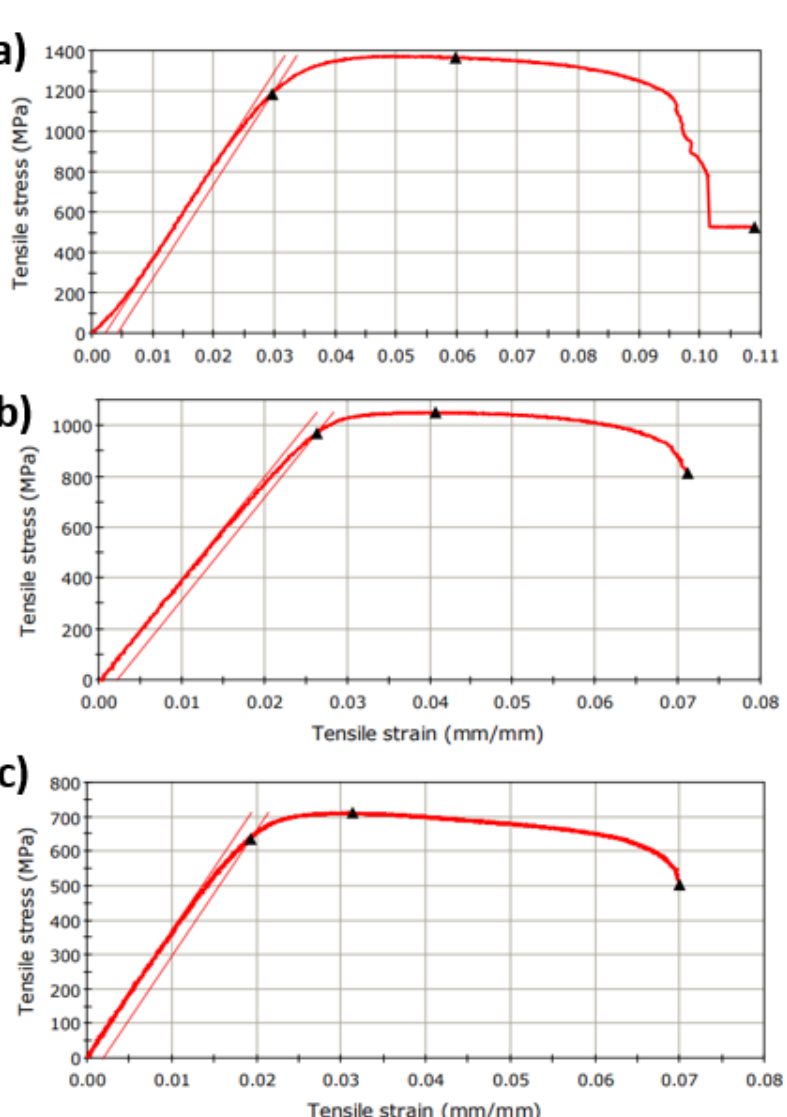
Figure 2. Stress–strain curves obtained on investigated alloys: ( a ) Ti20Mo7Zr5Ta, ( b ) Ti20Mo7Zr10Ta, ( c ) Ti20Mo7Zr15Ta. Table 1. Summary of tensile properties on investigated alloys.